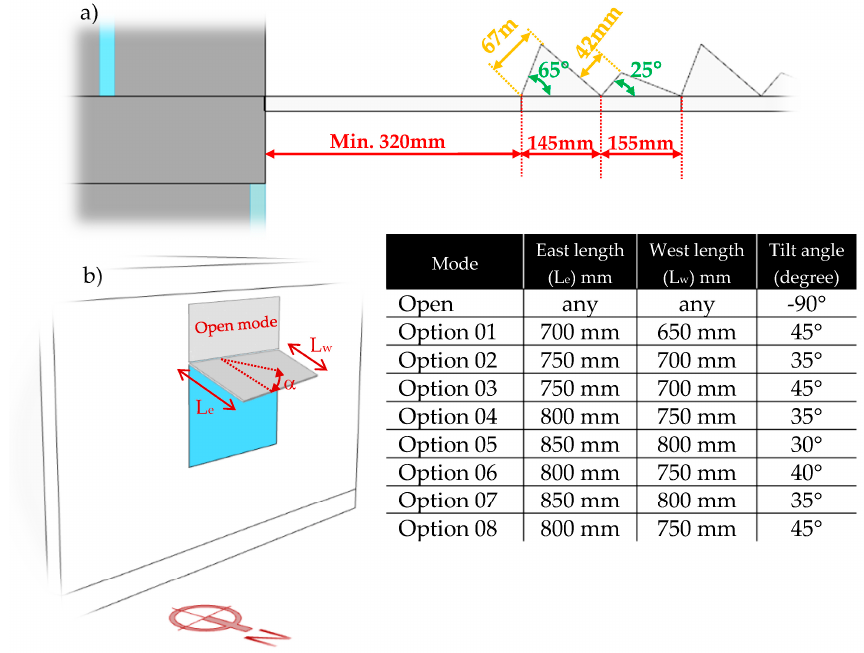
Figure 11. ( a ) Optimum surface of SLS top surface; and ( b ) eight optimum options for shade operation.